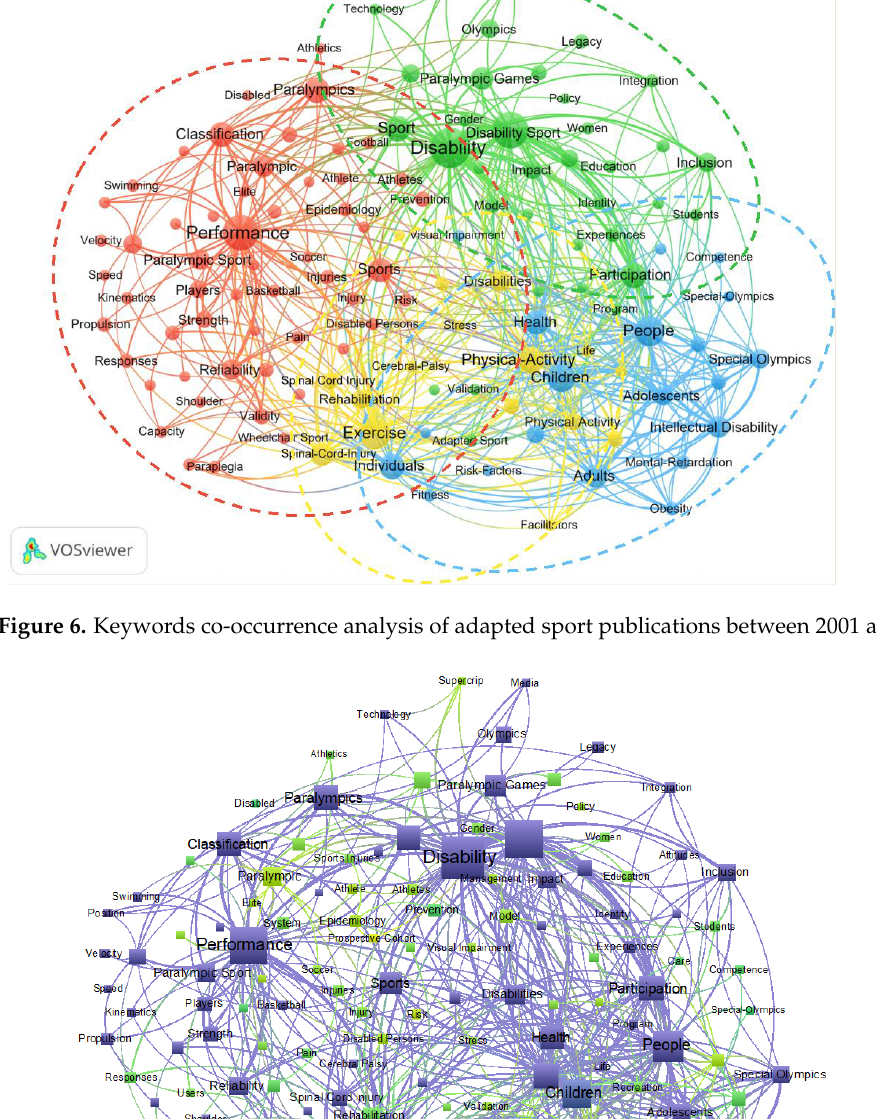
Figure 8. Keywords co-occurrence analysis of adapted sport publications between 2016 and 2020 with timeline.